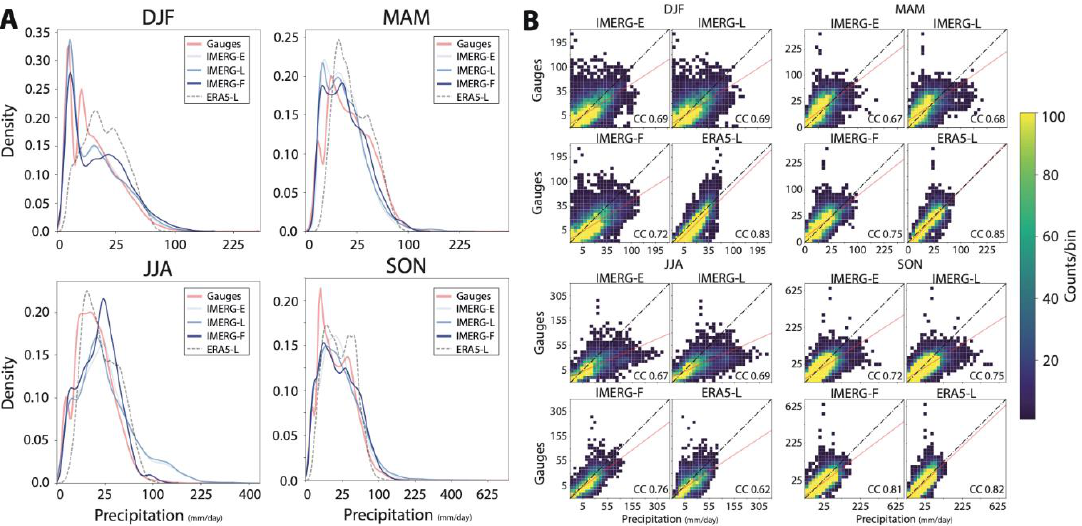
Figure 9. ( A ) Seasonal density plots of precipitation for gauges, IMERG-E, IMERG-L, IMERG-F, and ERA5-L. ( B ) Scatter plots comparing seasonal precipitation at every grid point.